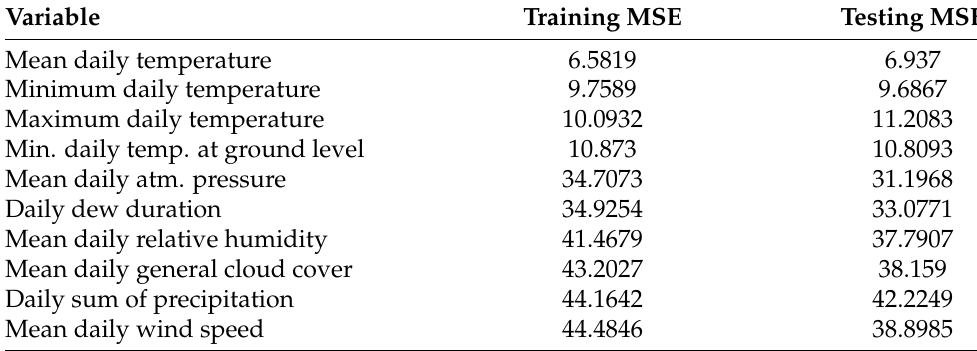
Table A8. The results of the selection of the most suitable subset of training variables for the prediction of the daily minimum